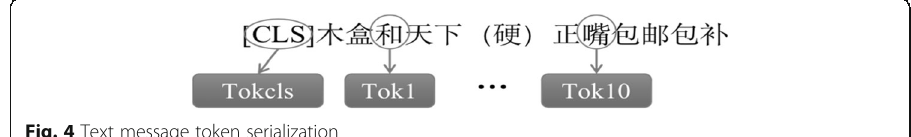
Fig. 4 Text message token serialization